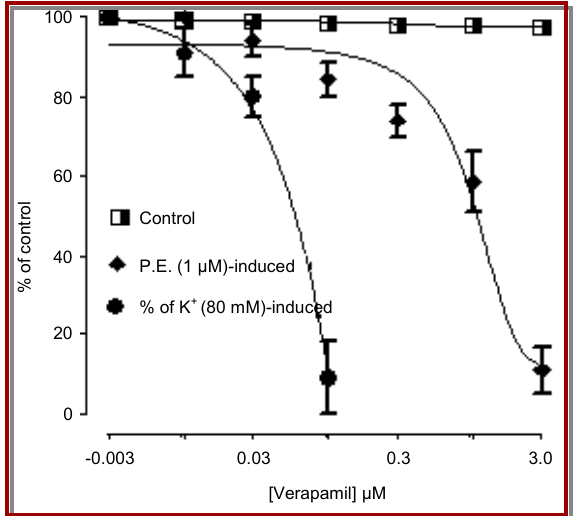
Figure 6 : Concentration-response curves showing inhibitory effect of (A) crude extract of B. wallichiana and (B) verapamil against K + (80 mM)- and phenylephrine (1 µM)-induced con- tractions in isolated rabbit aortic preparations (values are expressed as mean ± SEM, n = 3)